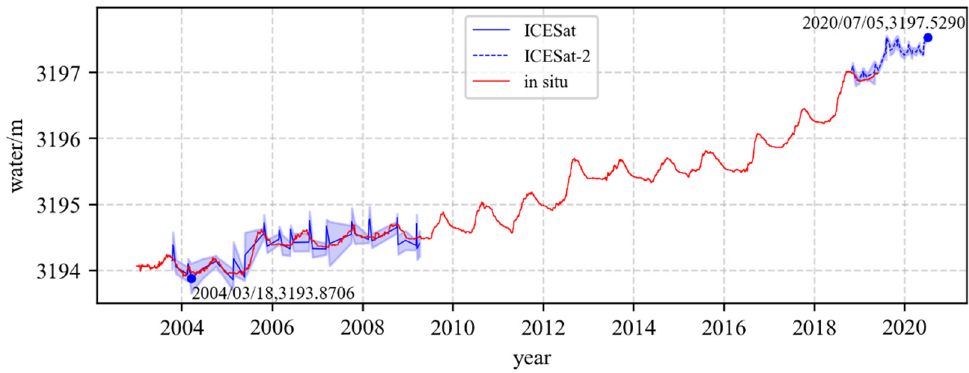
Figure 11. The change and uncertainties in water level derived from ICESat and ICESat-2 with the in situ hydrological station data for 2003–2020.